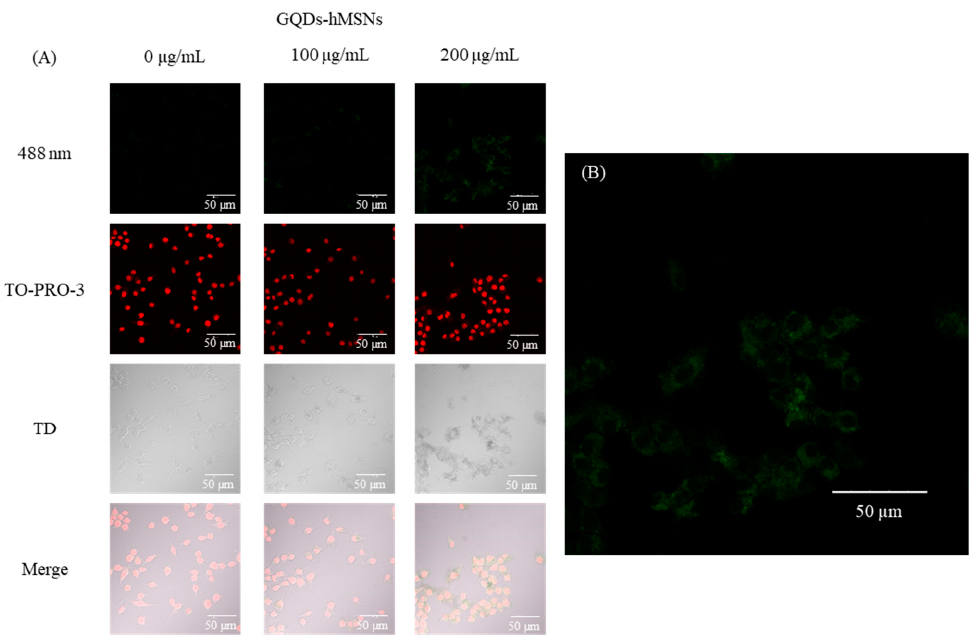
Figure 9. In vitro images of RAW 264.7 cells with GQDs-hMSNs. ( A ) 0, 100, and 200 µg/mL cell cultures with TO-PRO-3 labeled nucleus. ( B ) 200 µg/mL GQDs-hMSNs using the 488 nm laser showed a weak fluorescence signal. Transmitted (TD) and merged images depict the cell integration of GQDs-hMSNs in the cytoplasm.